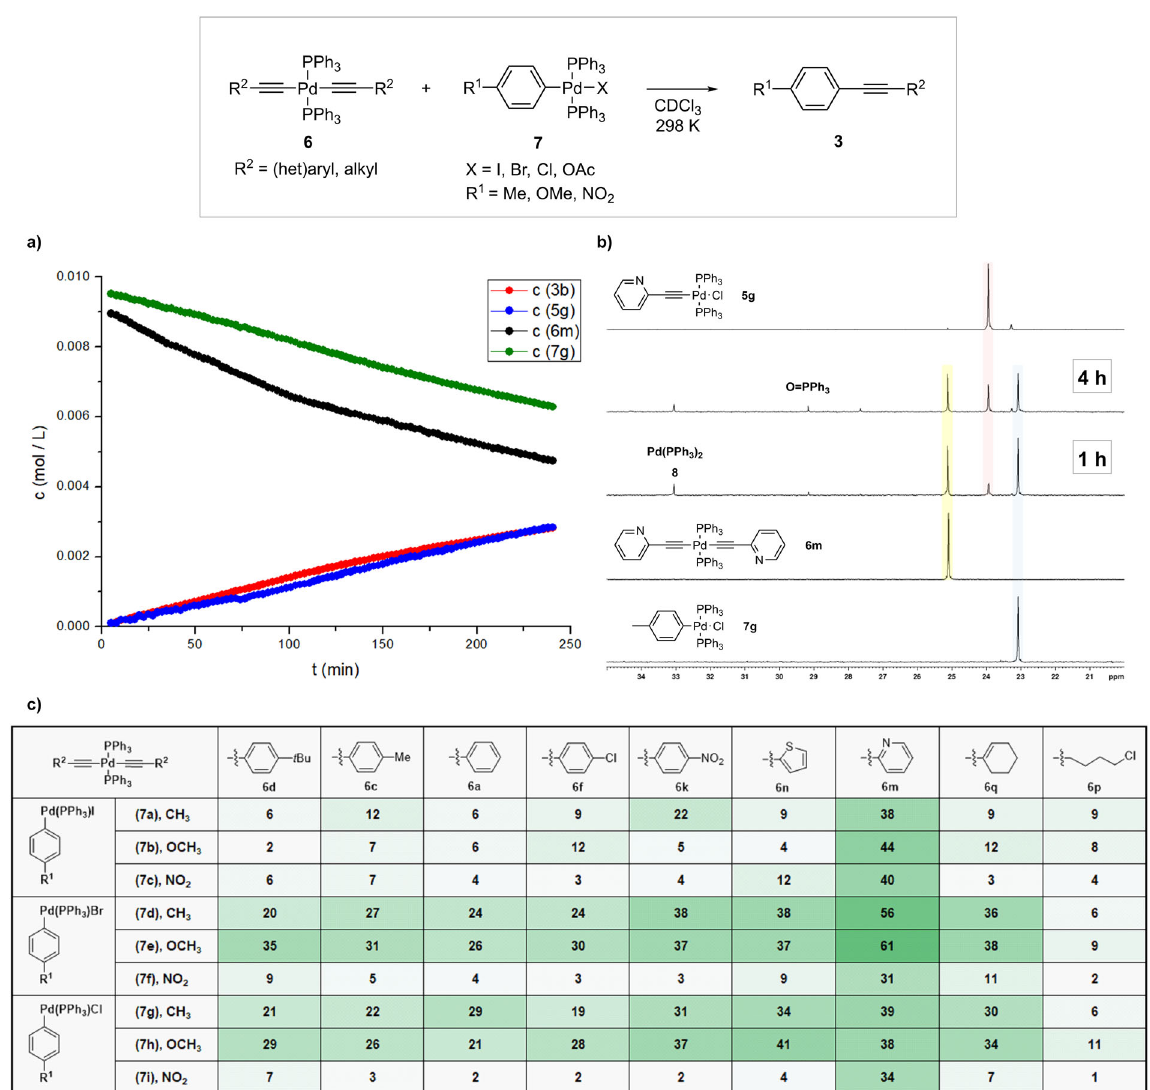
Fig. 6 Probing transmetallation reactions of 6 and 7. Example of monitoring the transmetallation reaction a concentration/time plot of key species ( 3b , 5 g , 6 m , 7 g ) and b stack of 31 P NMR spectra of reaction between 6 m (0.01 M) and 7 g (0.011 M). c The conversion into tolan product 3 after 2 h at 298 K as determined by 1 H NMR is reported. Conditions 6 (0.01 M) and 7 (0.01 M) in CDCl 3 , 298 K, 2 h. Concentration of starting complexes was comparable